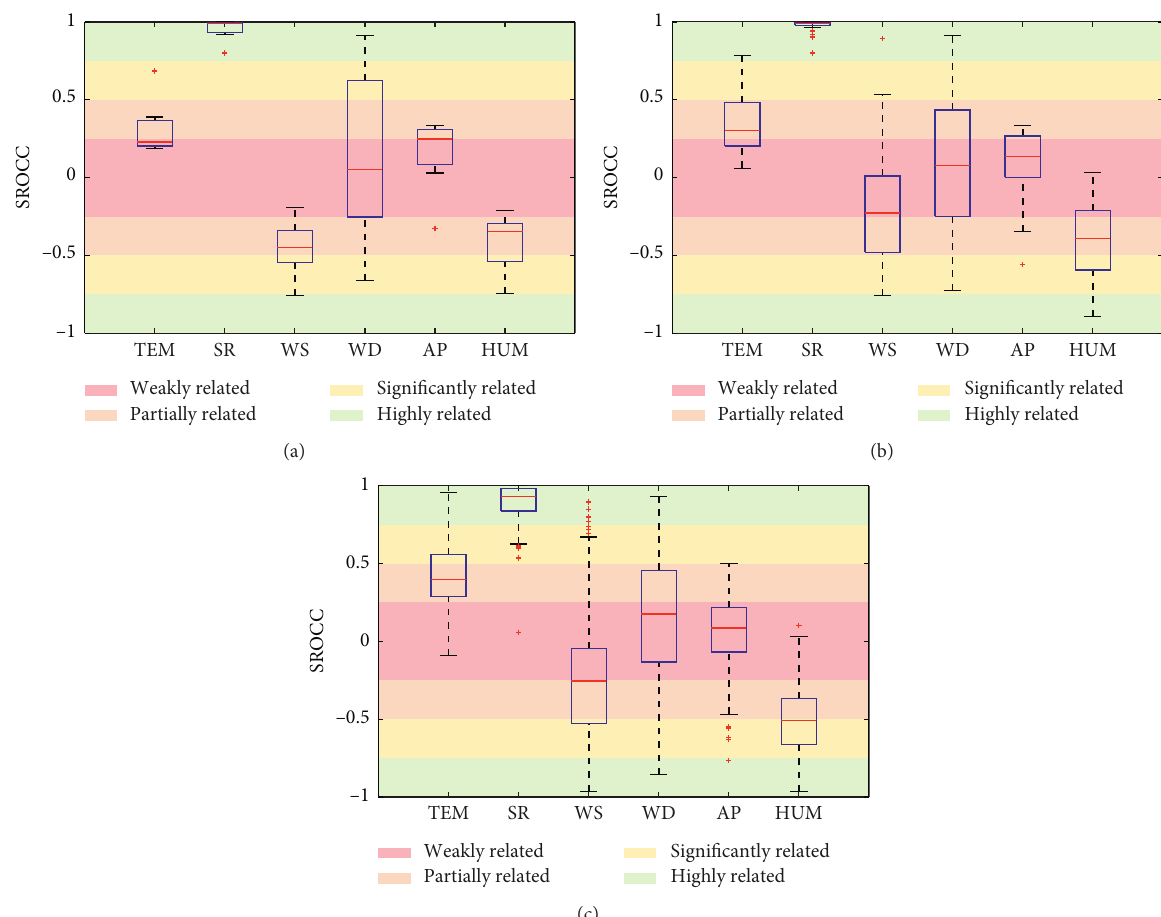
Figure 4: Box-whisker plot of SROCC of each type of factors in three different timescales: (a) a week, (b) a month, and (c) 6 months. TEM refers to temperature; SR refers to solar radiation; WS refers to wind speed; WD refers to wind direction; AP refers to atmospheric pressure; and HUM refers to humidity.